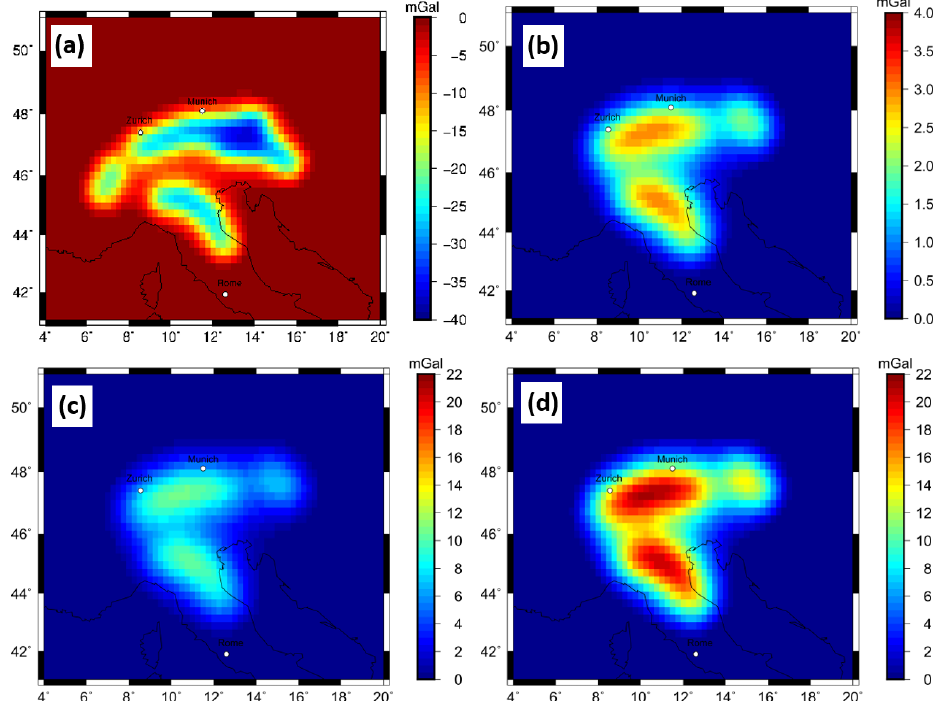
Figure 12. (a) Forward-calculated gravity effect of a Proterozoic lithospheric slab segment to a Tecton compositional surrounding mantle for Configuration 2, obtained by calculating the residual between M 8 and M 0 . (b) Gravity signal produced by purely compositional effect in the sublithosphere between a PUM and DMM composition, obtained by calculating the residual between M 5 and M 6 . (c) Gravity signal produced by purely thermal anomaly of − 100K for a sublithospheric slab segment, obtained by calculating the residual between M 3 and M 6 . (d) Gravity signal produced by purely thermal anomaly of − 200K for a sublithospheric slab segment obtained by calculating the residual between M 6 and M 7